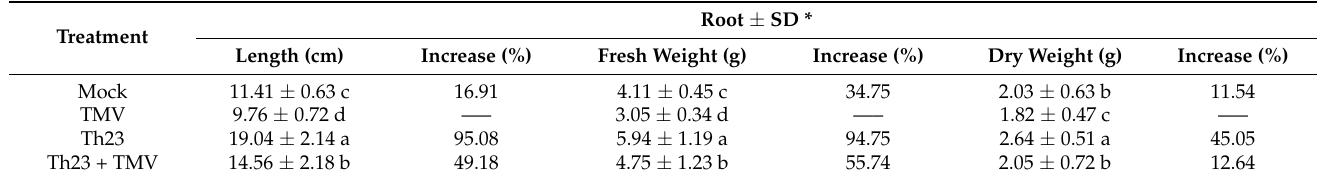
Table 3. The effect of different treatments of Th23 and TMV inoculation on the length, fresh, and dry weights of the root system in tomato